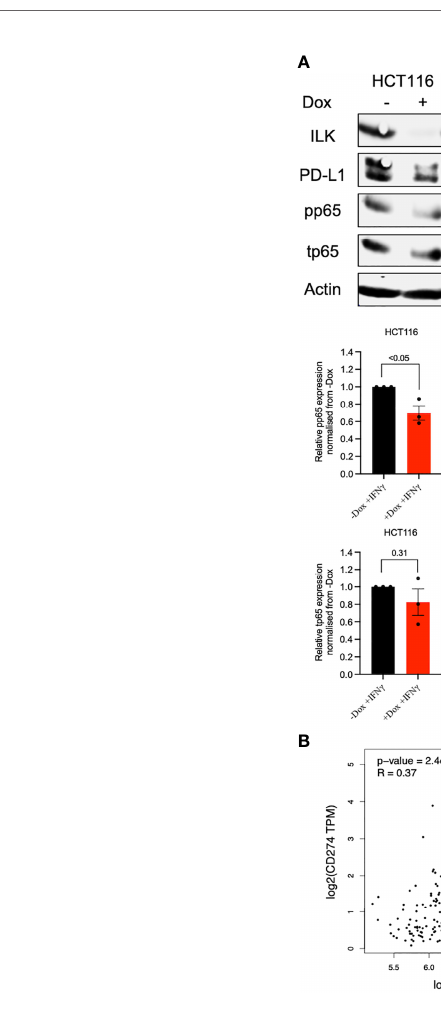
FIGURE 11 | ILK KD reduced IFN g -induced PD-L1 expression in the CRC cell lines in part via regulating NF- k B p65. [ (A) , upper] western blot showing NF- k B p65 (total and phosphorylated) protein expression in CRC cell lines stimulated with IFN g (50 ng) for 24 hr. [ (A) , lower] the quantitation of NF- k B p65 (total and phosphorylated) protein expression. Quantitation of proteins expression normalized to -Dox. Actin was used as an internal control. Error bars are represented as mean ± SEM (n = 3). P -value was analyzed with an unpaired t-test. The signi fi cant P -value is < 0.05. [ (B) , left] The correlation between ILK and CD274 gene expression in COAD tumors via GEPIA. [ (B) , right] The correlation between ILK and Rela gene expression in COAD tumors via GEPIA. R is Spearman ’ s Rho values. Signi fi cant P -value is <